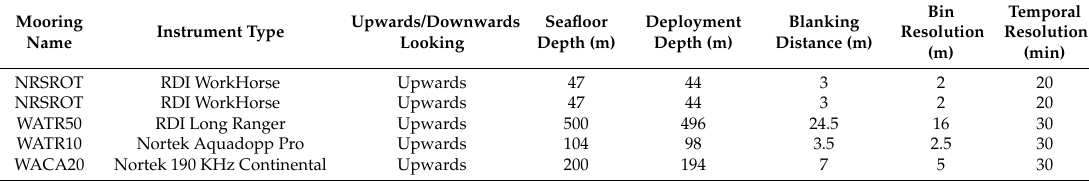
Table 1. Details of the mooring in the Rottnest Shelf region. See Figure 1 for their locations within the HFR coverage area. NRSROT, WATR50, WATR10 and WACA20 stand for Rottnest Reference Station, WA Two Rocks 490 m, WA Two Rocks 103 m, and WA Perth Canyon 200 m moorings,